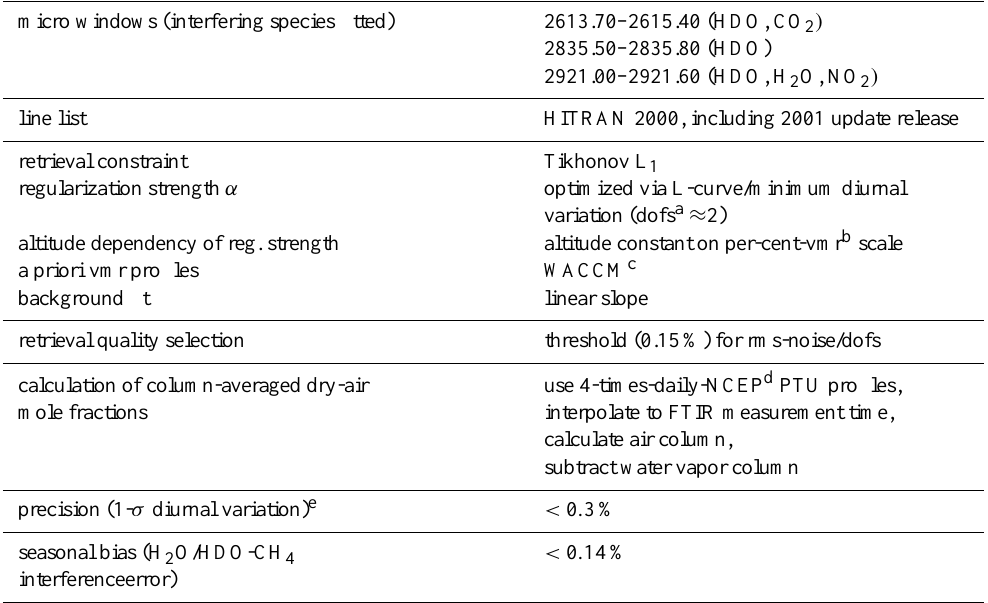
Table 1. Characteristics of the strategy for retrieval of column-averaged methane from mid-IR solar spectra (MIR-GBM v1.0). For more details, see Sussmann et al.